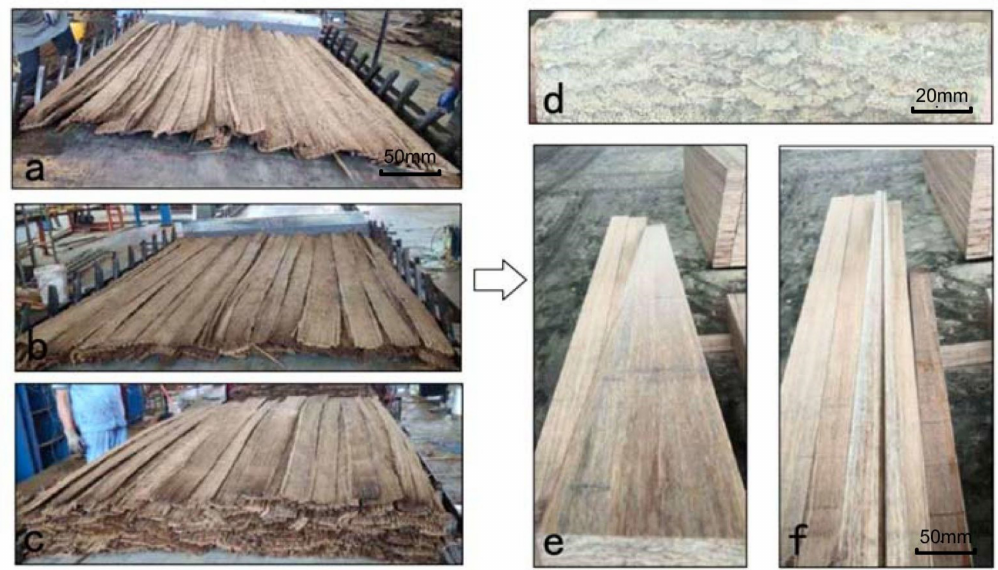
Figure 2. Bamboo fiber composite (BFC) formation: ( a ) first layer on caul plate, ( b ) mat build-up showing strips with minimal overlap of core strips, ( c ) finished lay-up, ( d ) cross-section of consolidated panel and ( e , f ) re-sawn billets from a BFC panel.